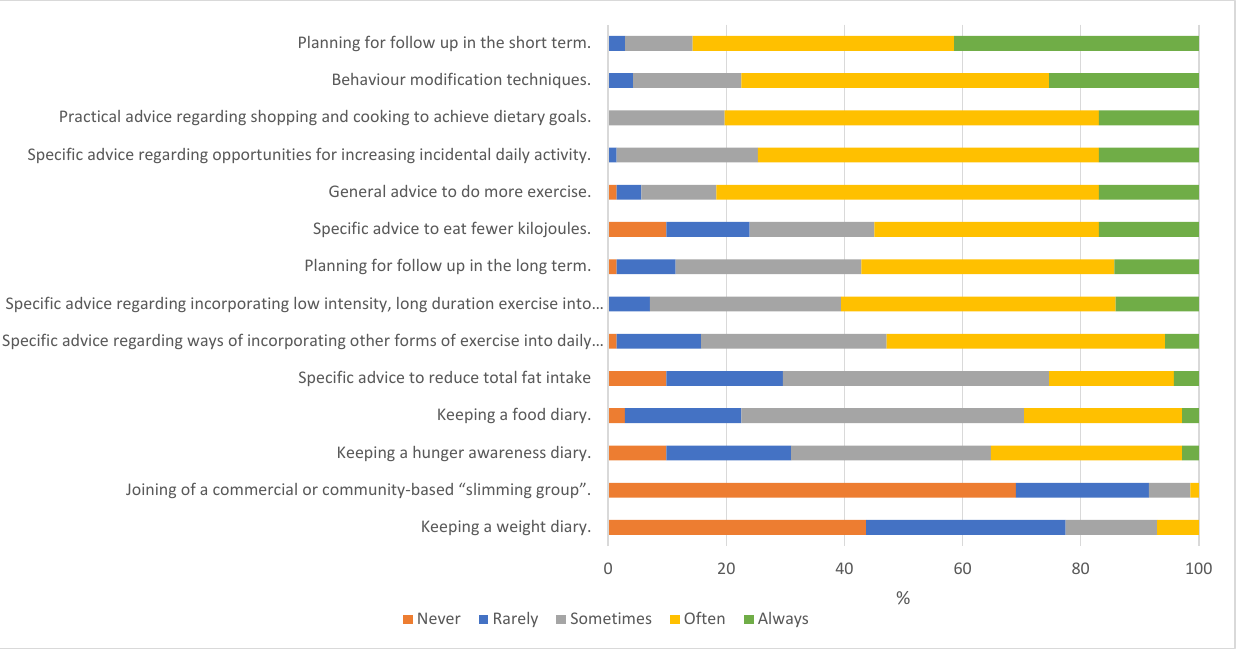
Figure 2. Alternative weight management approaches used by survey respondents.